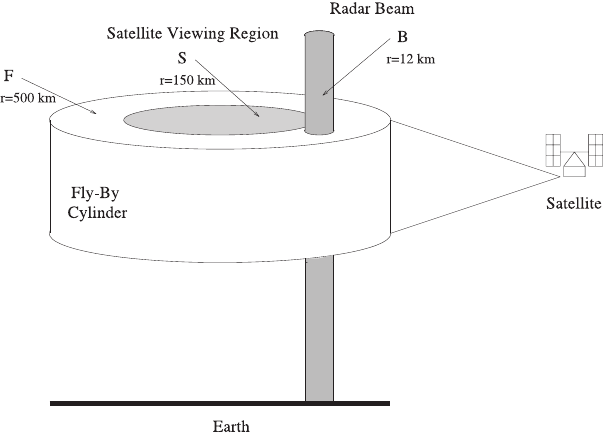
Fig. 2. Schematic diagram of an overpass. The satellite viewing region is represented by the cylinder S, the radar beam by the cylinder B and the outer limit of the overpass is denoted by the cylinder F. The radar beam B has to pass through the cylinder F for the observation to be considered an